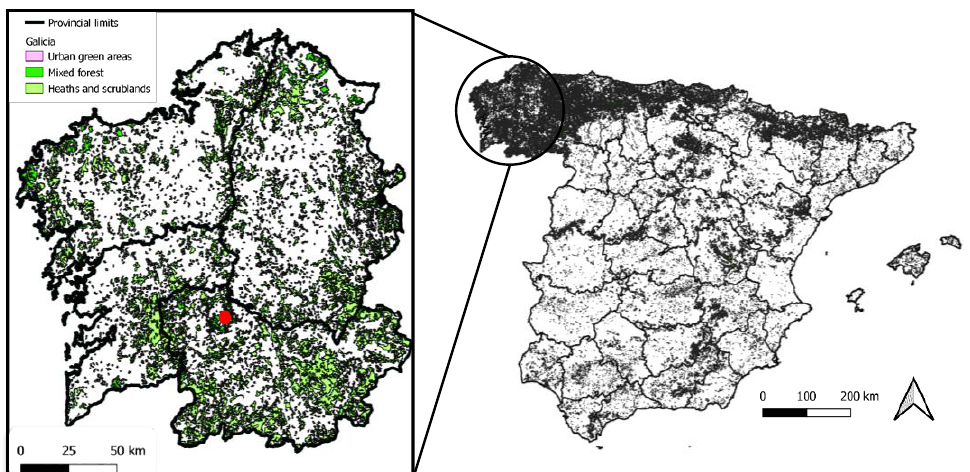
Figure 1. Sampling location area Ourense (red dot) and the surrounding land use by CORINE land cover.